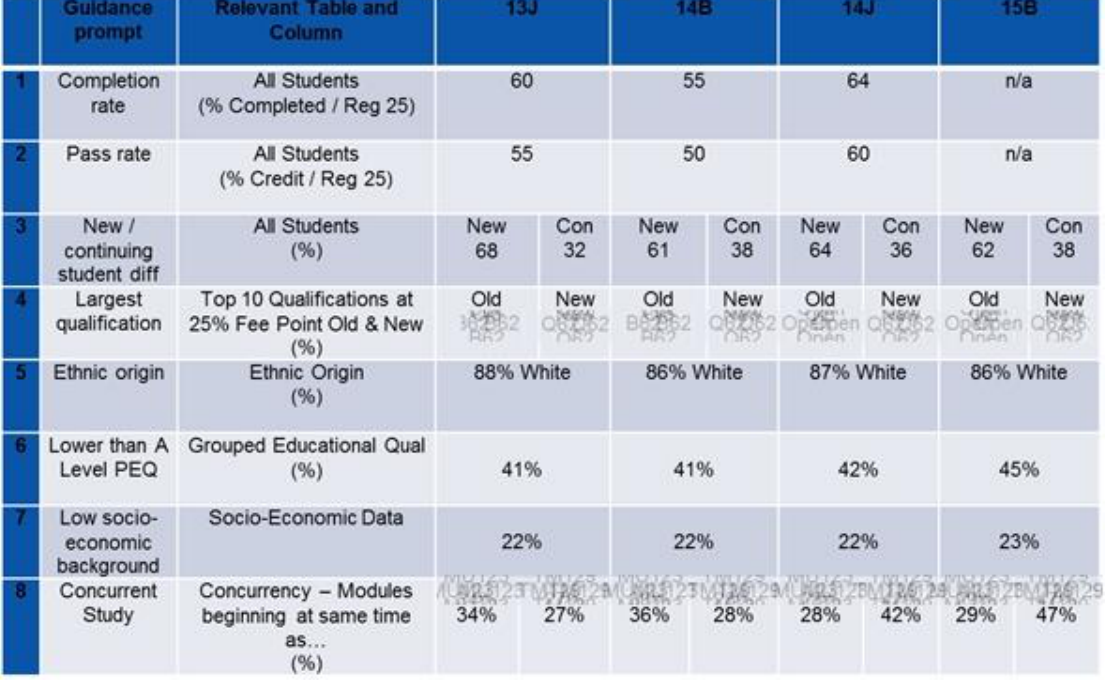
Breakdown of Composition of Students in